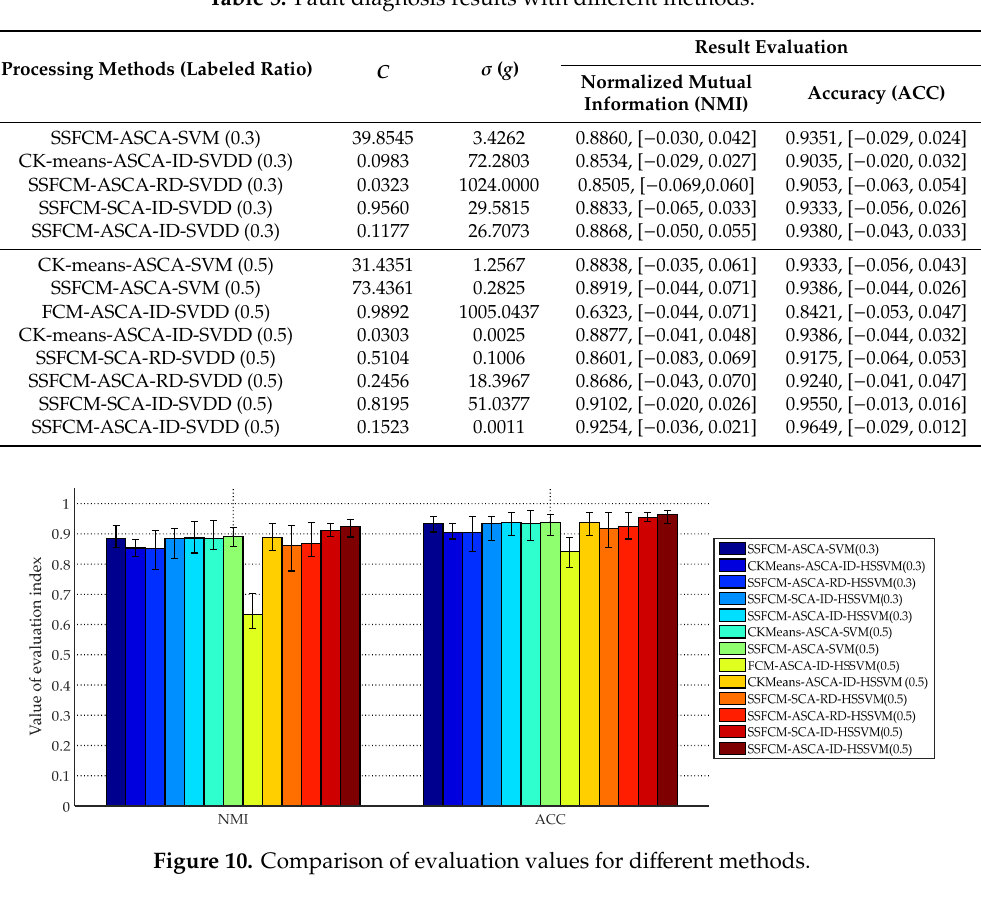
Table 5. Fault diagnosis results with di ff erent methods.